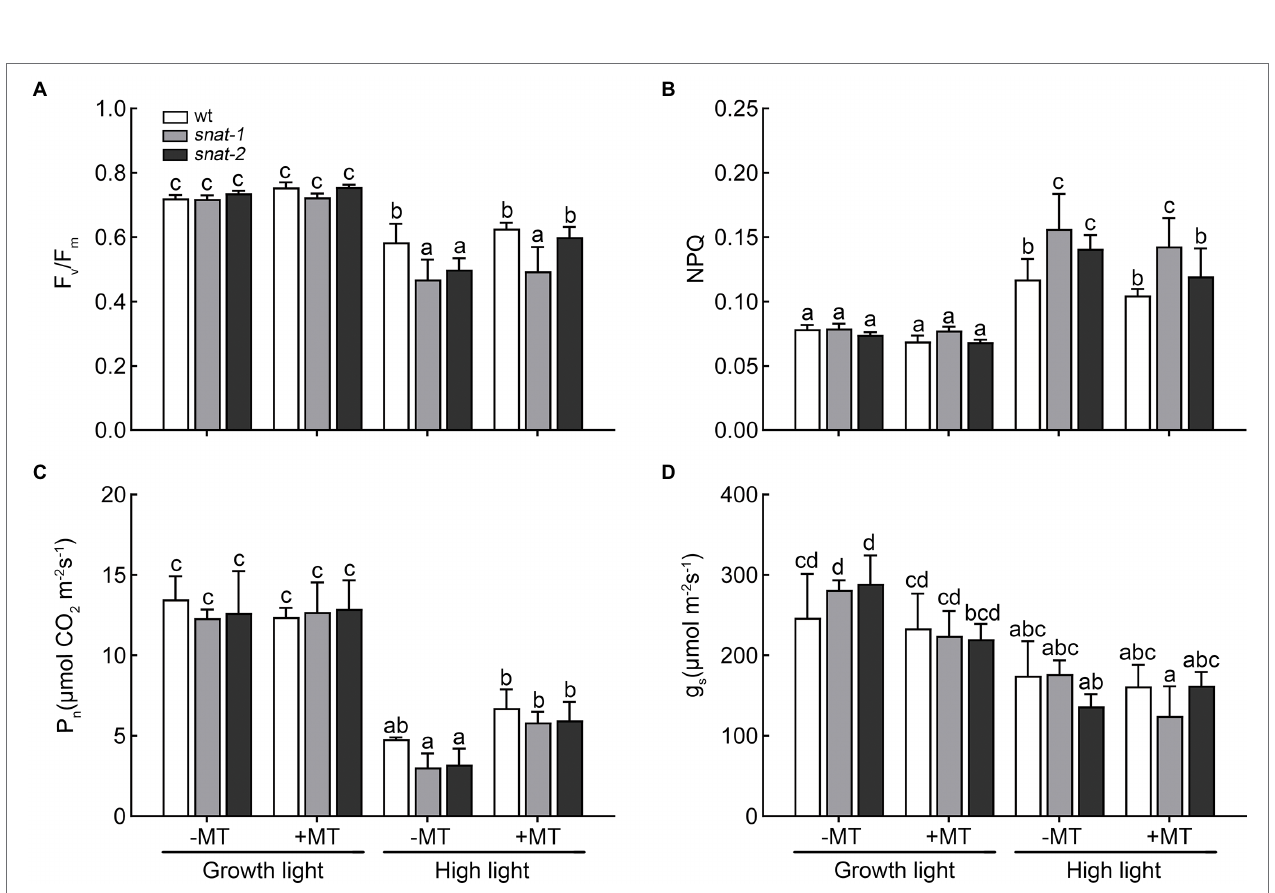
FIGURE 2 | Effects of exogenous melatonin on photosynthetic pigments. (A) The chlorophyll level. (B) The carotenoid level. Others are the same as in Figure 1 .